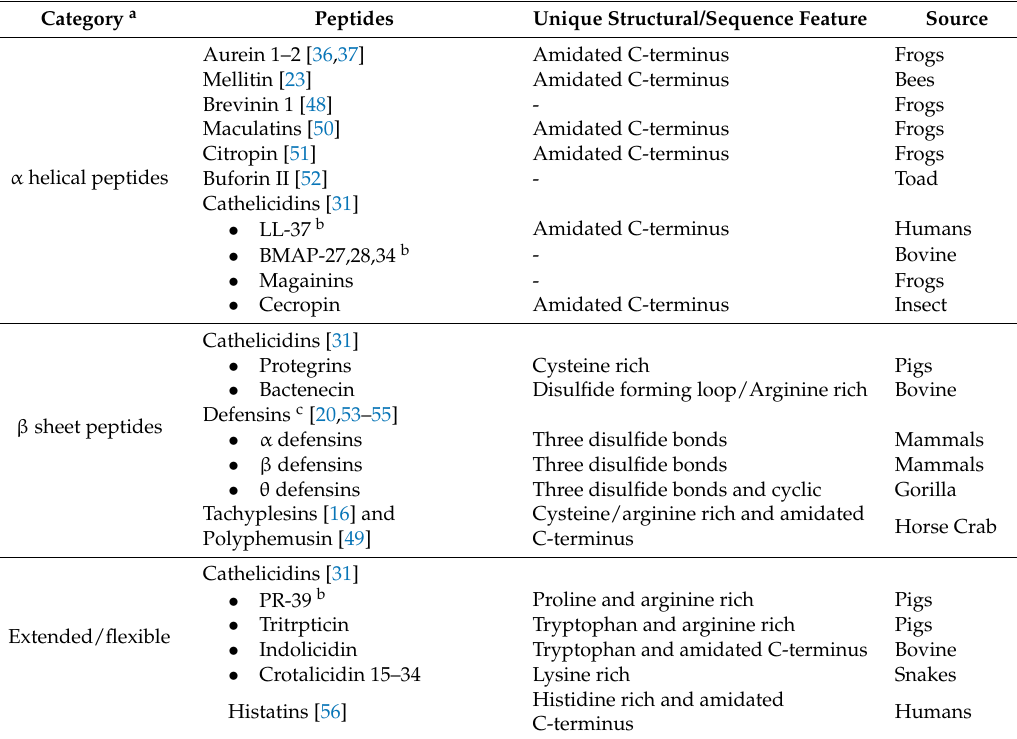
Table 1. Classes of antimicrobial peptides based on structure.